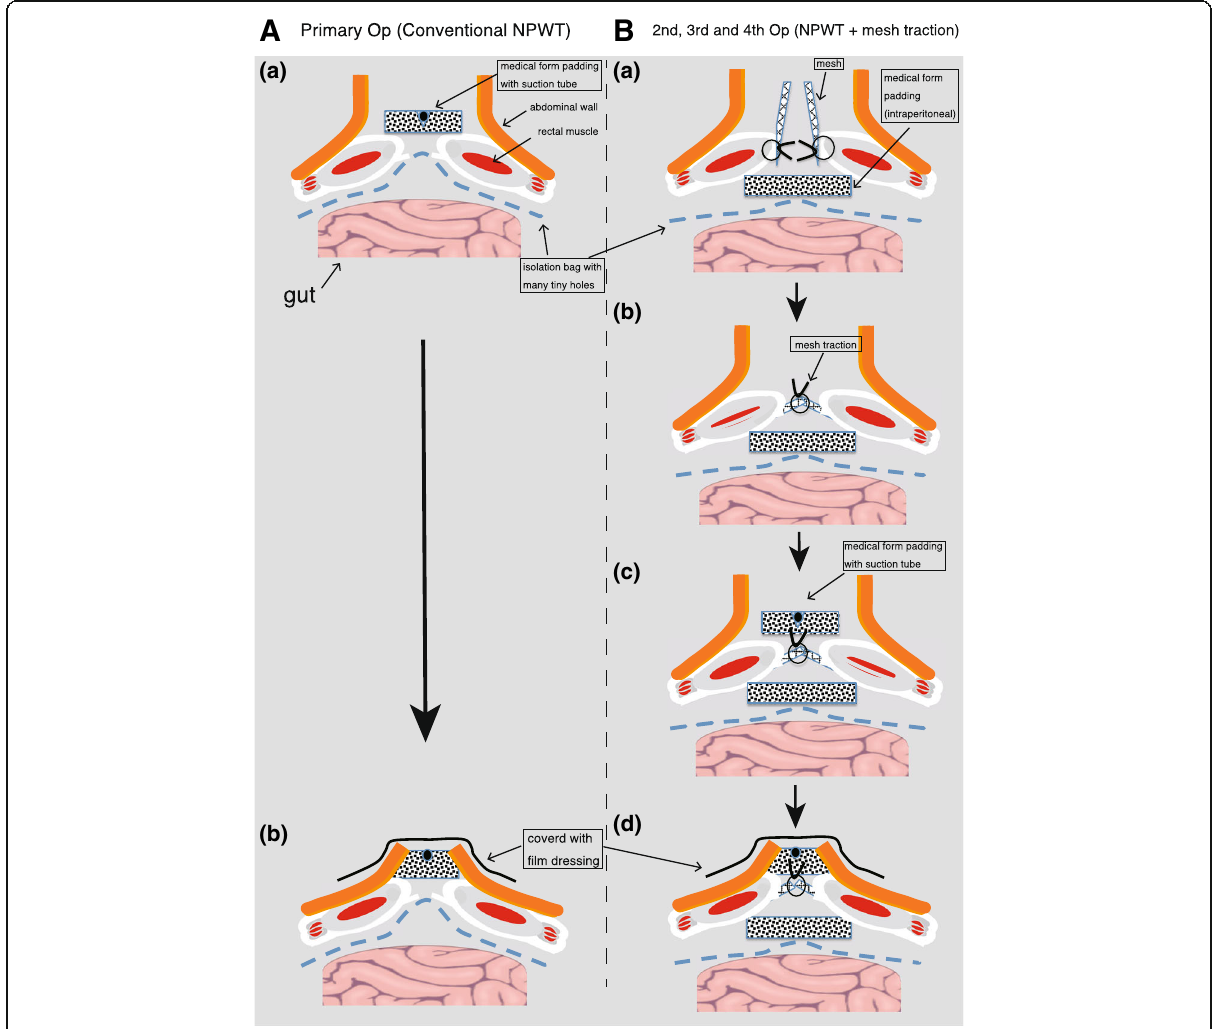
Fig. 5 Operative schemes. A Conventional NPWT at the primary operation. B NPWT with mesh traction at the second through fourth